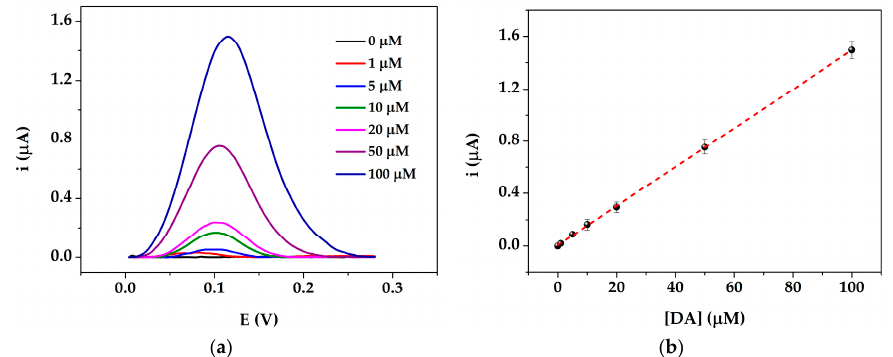
Figure 5. Dopamine detection at AuNPs@PANI / GSPE. ( a ) Di ff erential pulse voltammograms performed with di ff erent DA concentrations (0–100 µ M) in 0.1 M PBS pH 7.0. Experimental parameters: potential range from + 5 mV to + 600 mV, scan rate 4 mV / s, step potential 2 mV, pulse potential 50 mV, pulse time 0.05 s; ( b ) Calibration curve for DA. Each point was obtained at least 5 times using di ff erent sensors.